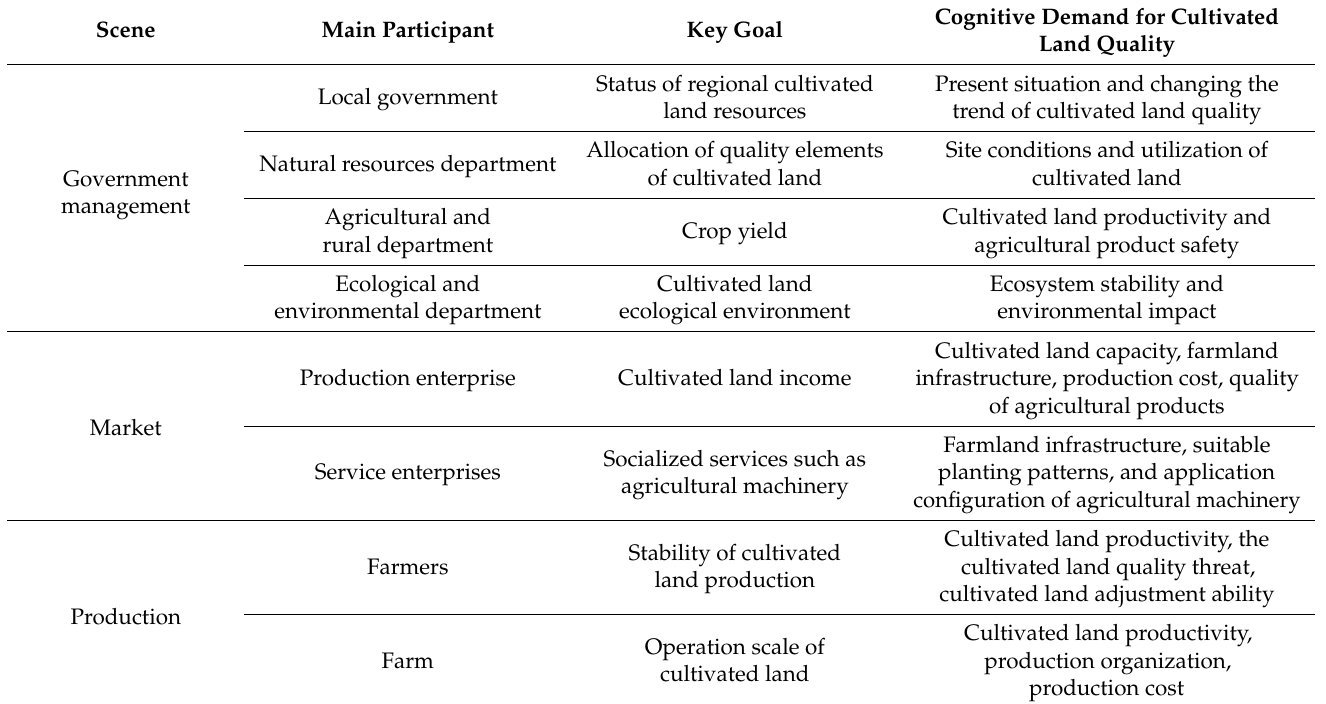
Table 3. Cognitive application scene of cultivated land quality in the black soil